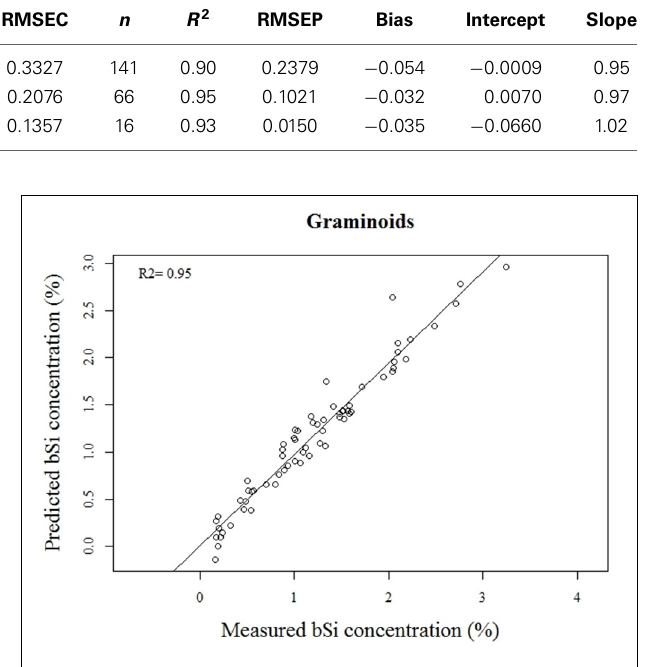
FIGURE 6 | Validation plot of the NIRS calibration model based on samples of